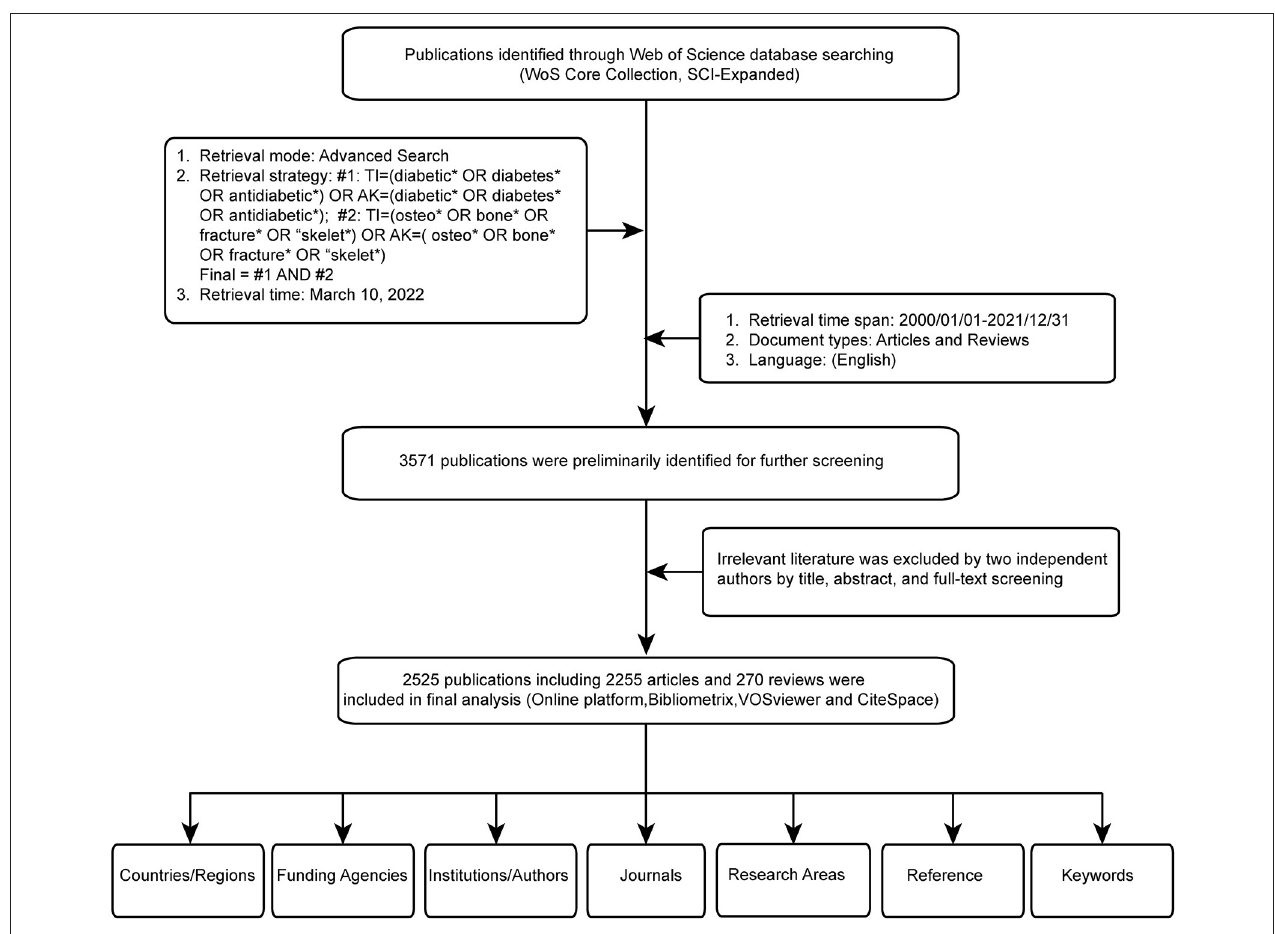
FIGURE 1 | Flowchart of literature search and selection